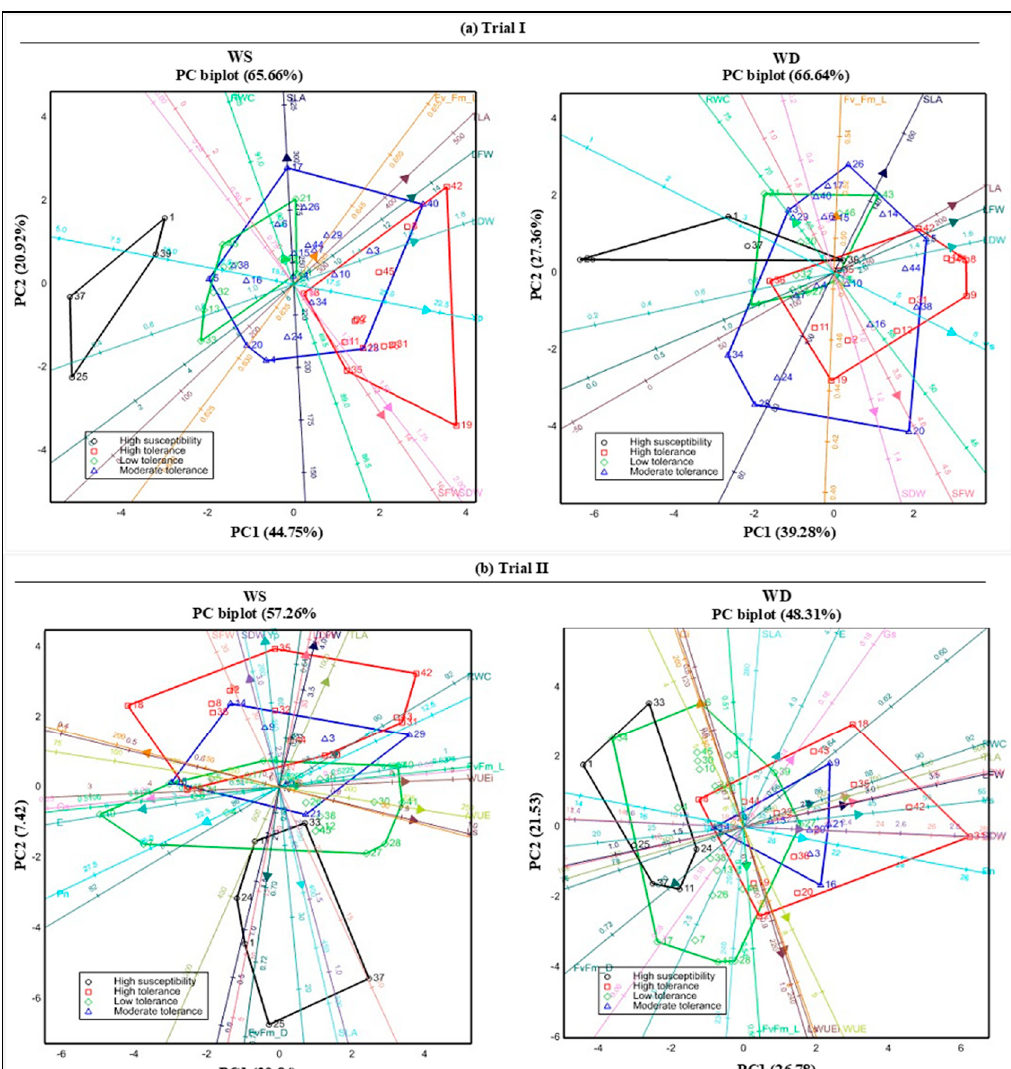
Figure 5. Principal component biplot on tolerance grouping in association with physiological responses under WS and WD conditions ( a ) in Trial I and ( b ) in Trial II.